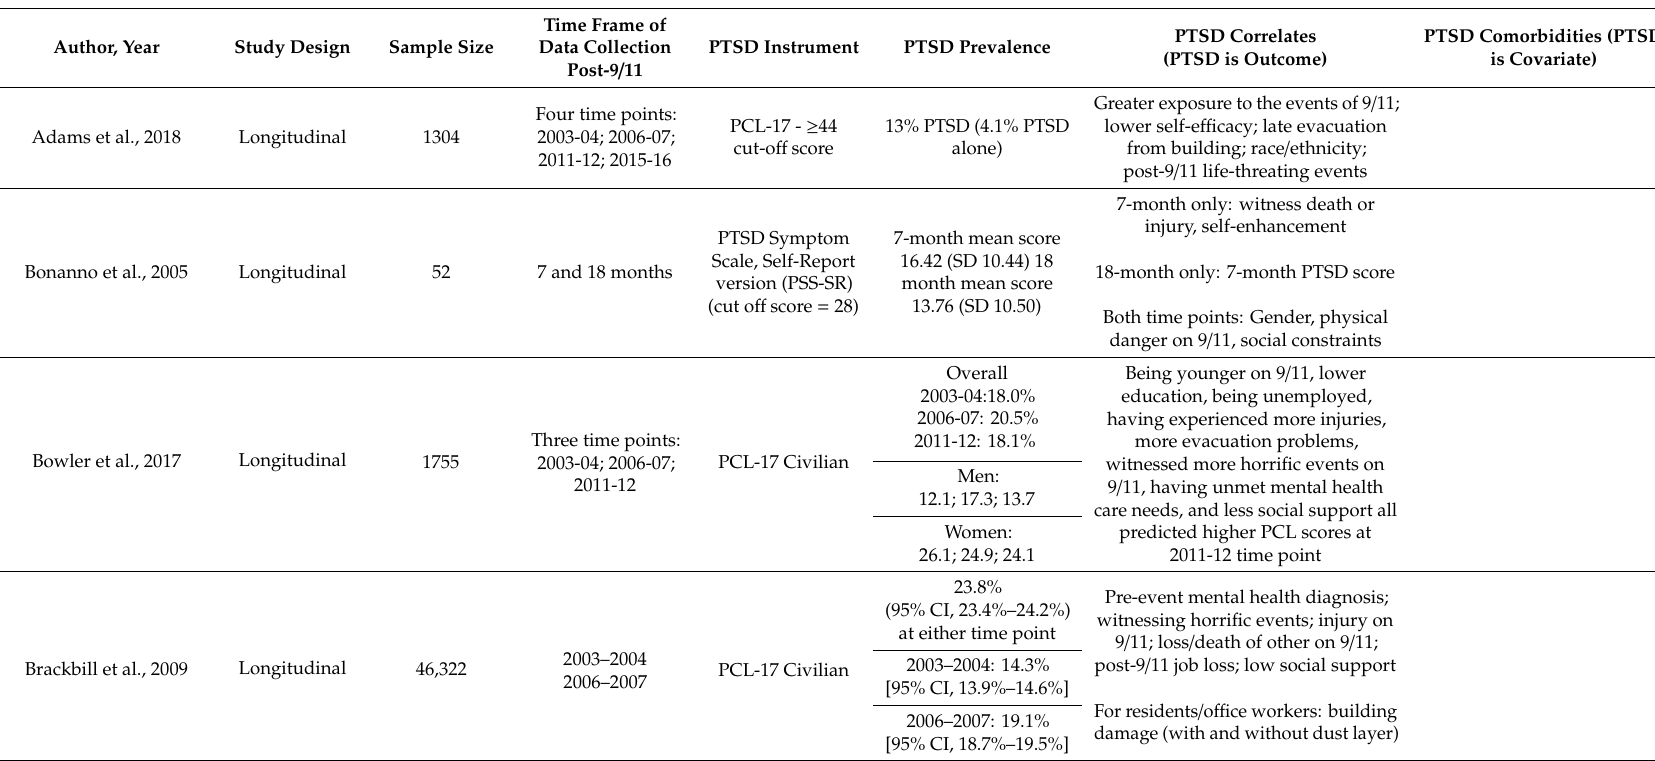
Table 1. Data extracted from all included studies. PTSD: post-traumatic stress disorder; SD: Standard Deviation; LRS: Lower Respiratory Symptoms;